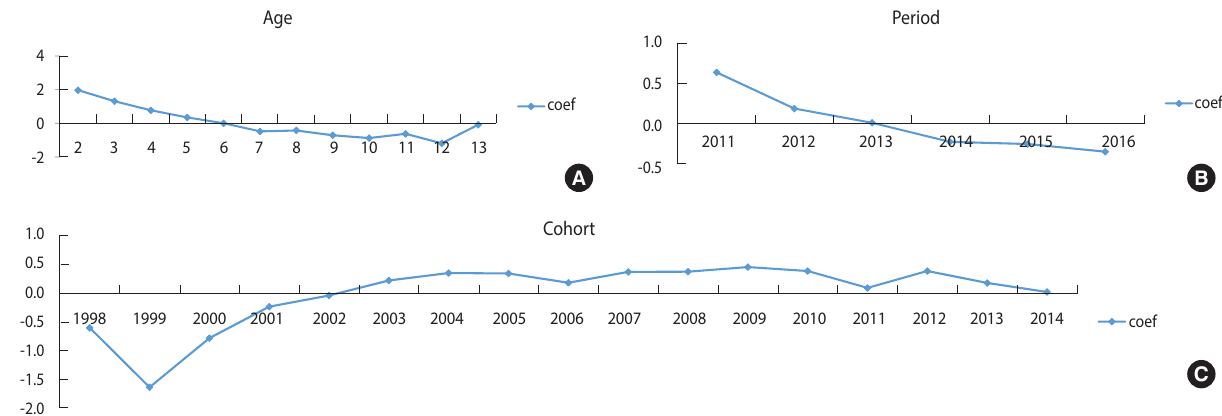
Figure 4. Intrinsic estimator (coef) of age (A), period (B), cohort (C) effect from annual age-specific crude incidence rates (1,000 person) of varicella by age (2-13 years old) and calendar year (2011-2016) in children in Jeju-do, Republic of Korea.